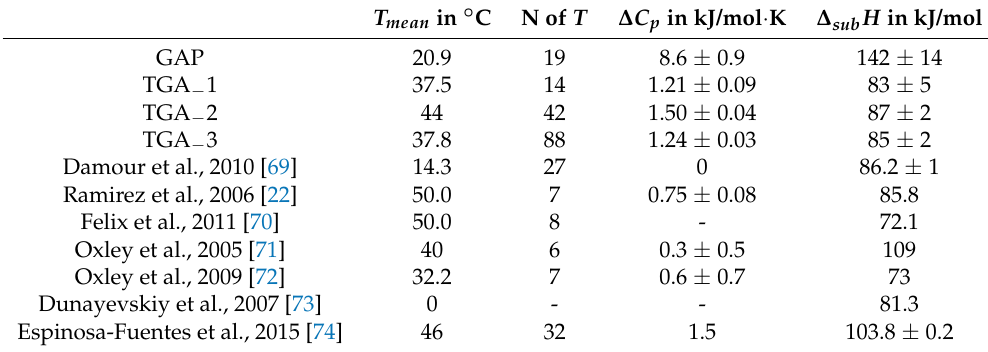
Table 3. Enthalpies of sublimation and ∆ C p values for TATP from this study and the